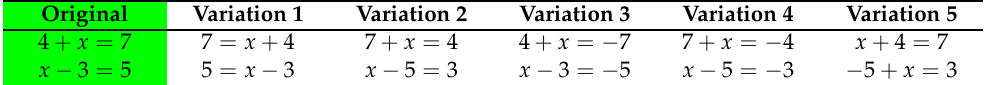
Table 3. Examples of type 1 and type 2 equations and variations.